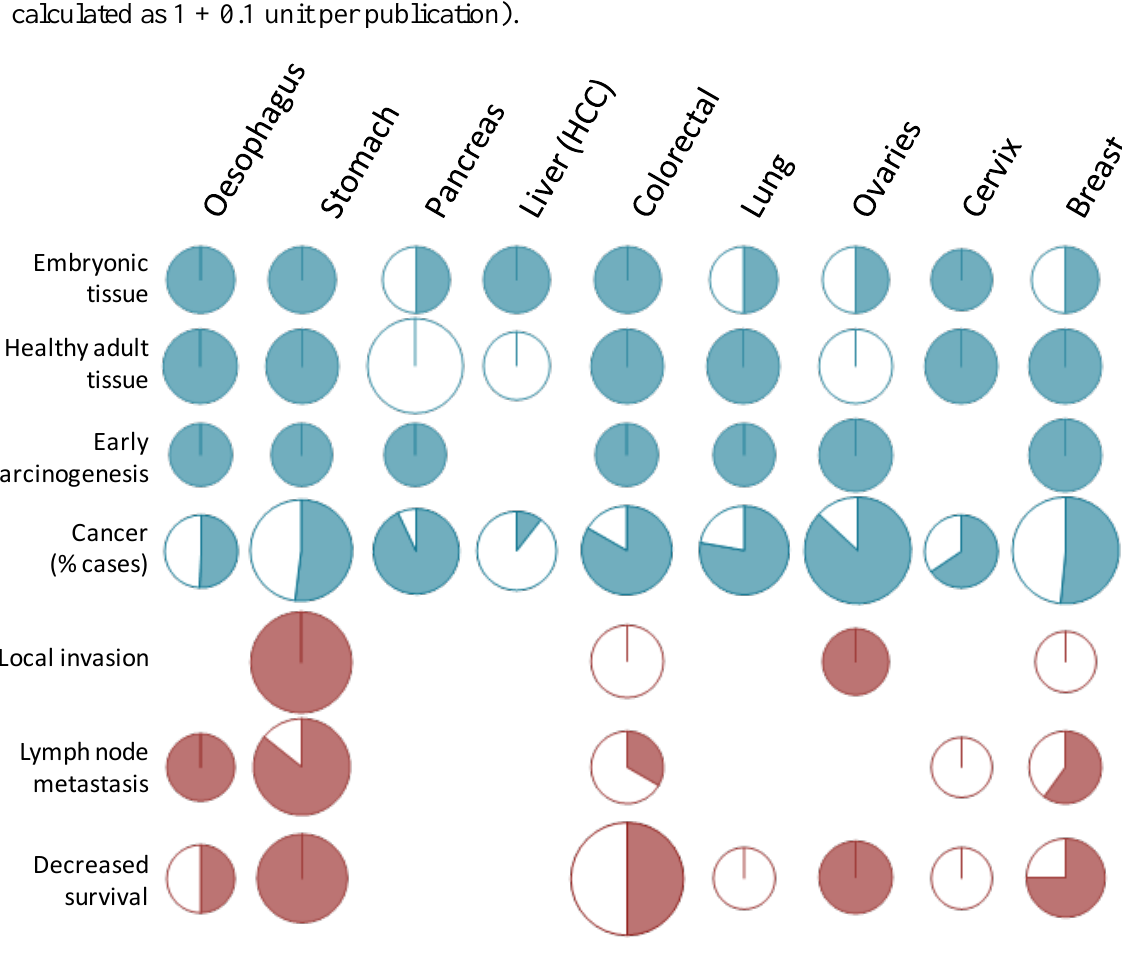
published papers reviewed herein sorted by cancer type. Top part: reports of positive (blue) or negative (white) expression in various tissues and cancer. For first and second lines, positive expression relates to a sparse and low expression as described in Sections